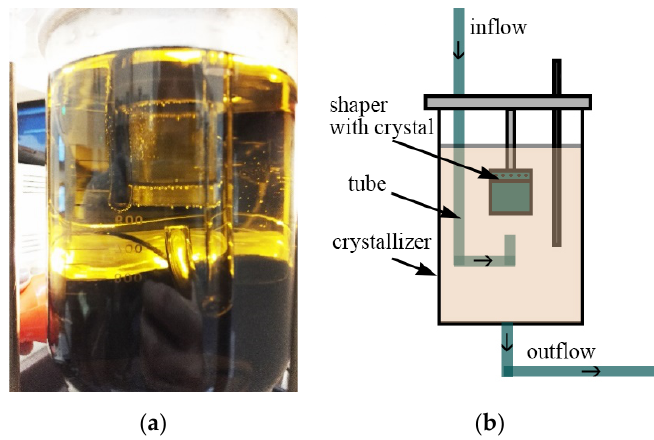
Figure 1. The photo ( a ) and the scheme ( b ) of an experimental crystallizer for K 2 (Co,Ni)(SO 4 ) 2 •6H 2 O (KCNSH) crystal growth by temperature difference technique.